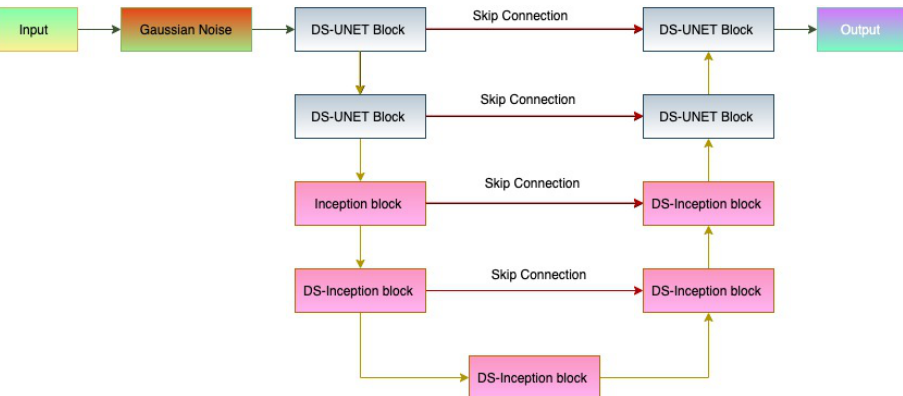
Figure 12. Fourth proposed architecture: Depth-wise separable Hybrid recurrent-inception